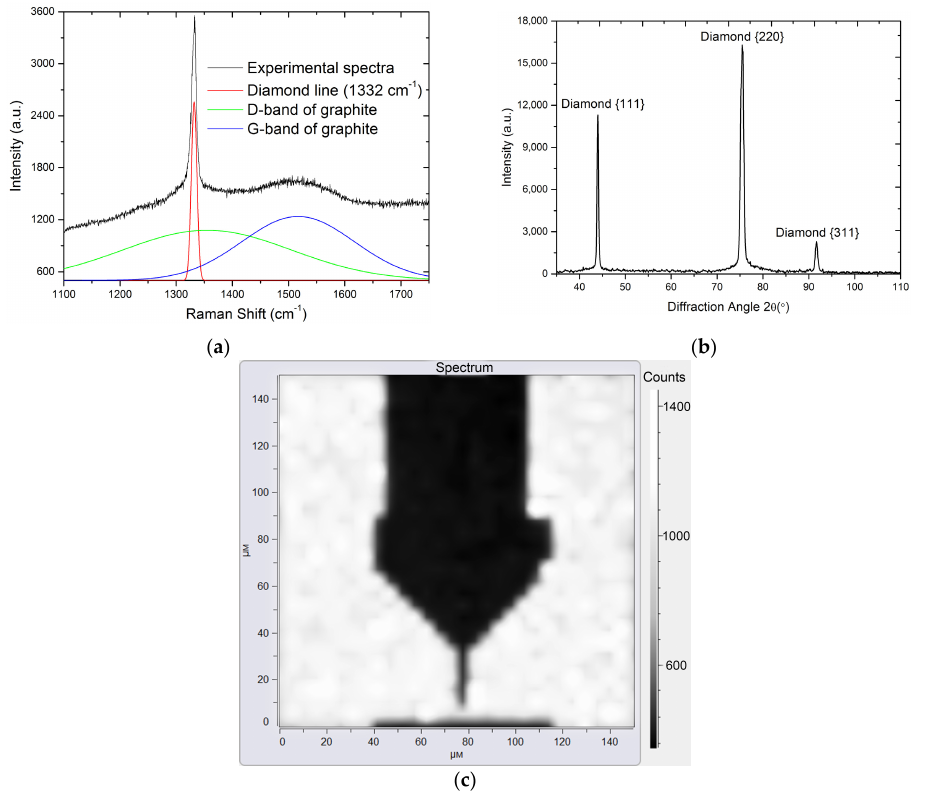
Figure 7. Raman ( a ) and X ‐ ray diffraction ( b ) spectra of diamond film; ( c ) Raman mapping.